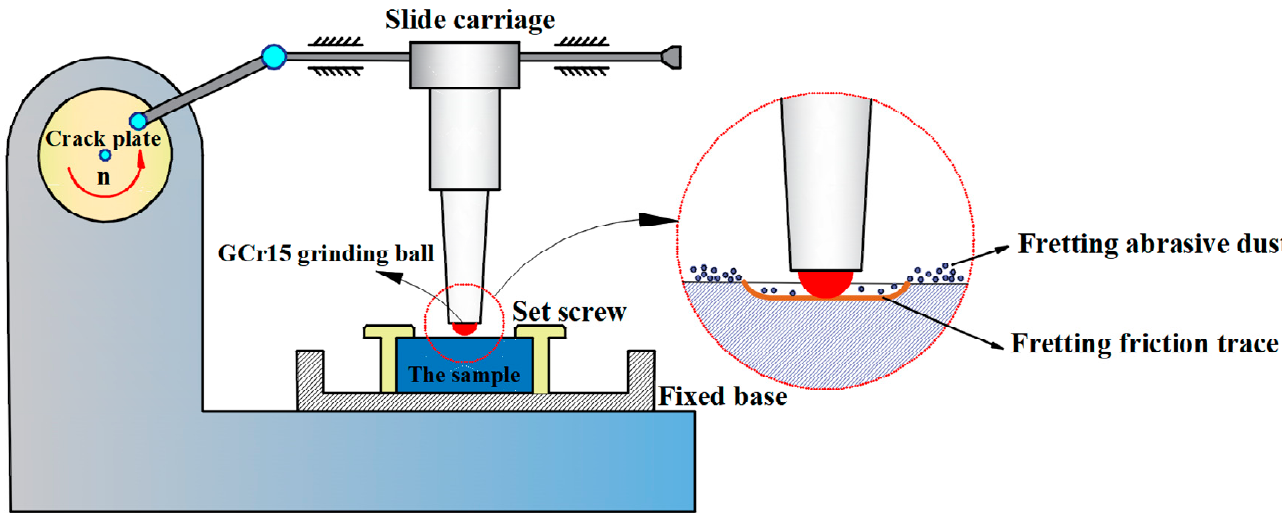
Figure 2. Schematic diagram of the friction and wear experiment.